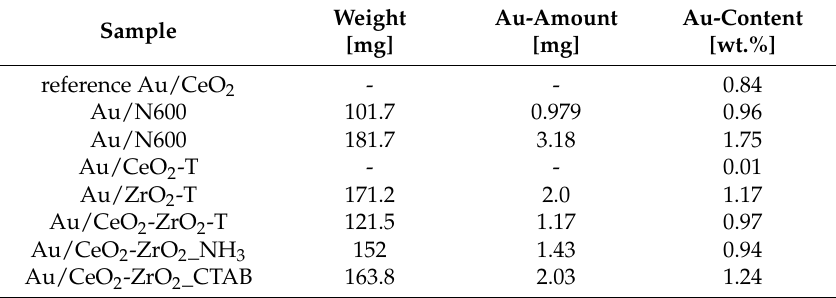
Table 1. Weight percentages of gold in Au/ceria, Au/zirconia, and Au/ceria-zirconia mixed oxides. Weight Au-Amount Au-Content Sample [mg] [mg] [wt.%] reference Au/CeO 2